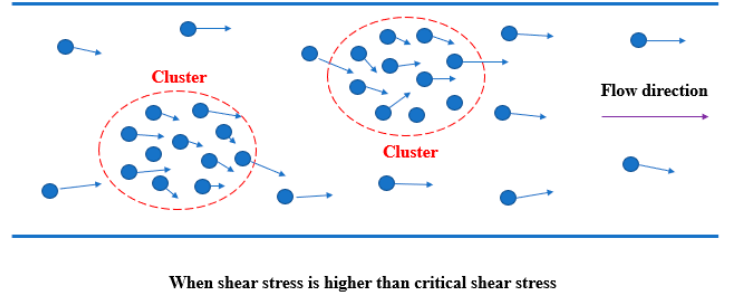
Figure 1. Schematic diagram of cluster formation theory. The Peclet number in Equation (1) is used to measure the relative magnitude of hydrodynamic viscosity under the hydrodynamic force and Brownian viscosity under the repulsive force [14]. Brownian viscosity is dominant when the value of the Peclet is lower than 1. Brownian viscosity gradually decreases and hydrodynamic viscosity